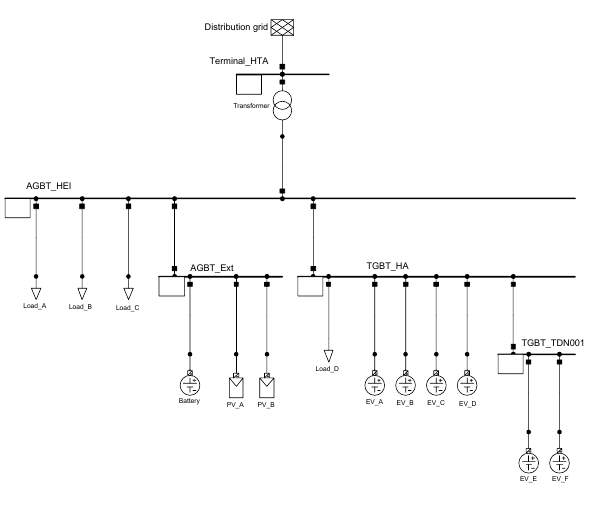
Figure 4. Physical model of the grid